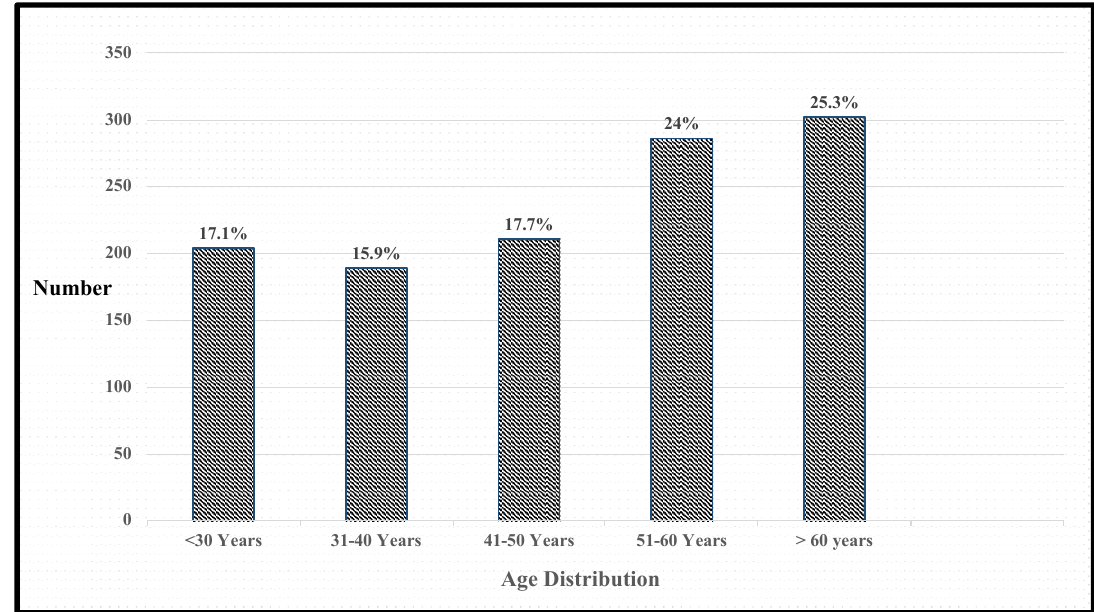
Figure 1. Age-wise distribution of COVID-19 patients.